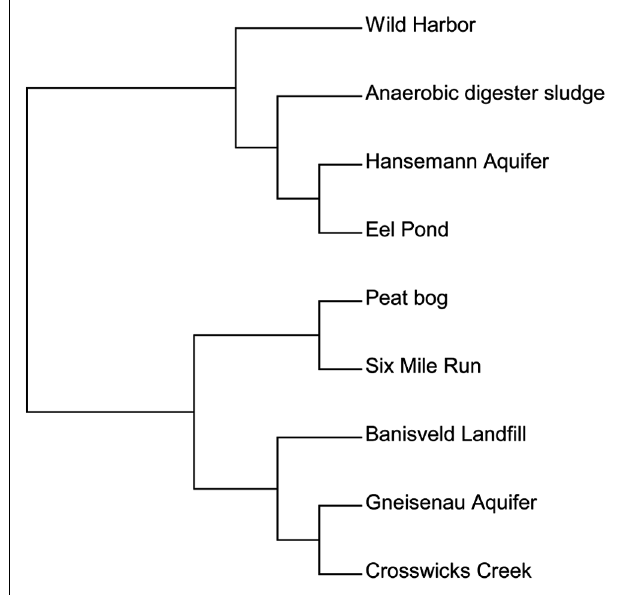
FIGURE 3 |A functional OTU-based cluster analysis of environmental samples based on location. Amino acid sequences from all published culture-independent surveys were compared over an 81 amino acid region of the BamA hydrolase. Sites were compared using mothur software (Schloss etal., 2009) with a 95%